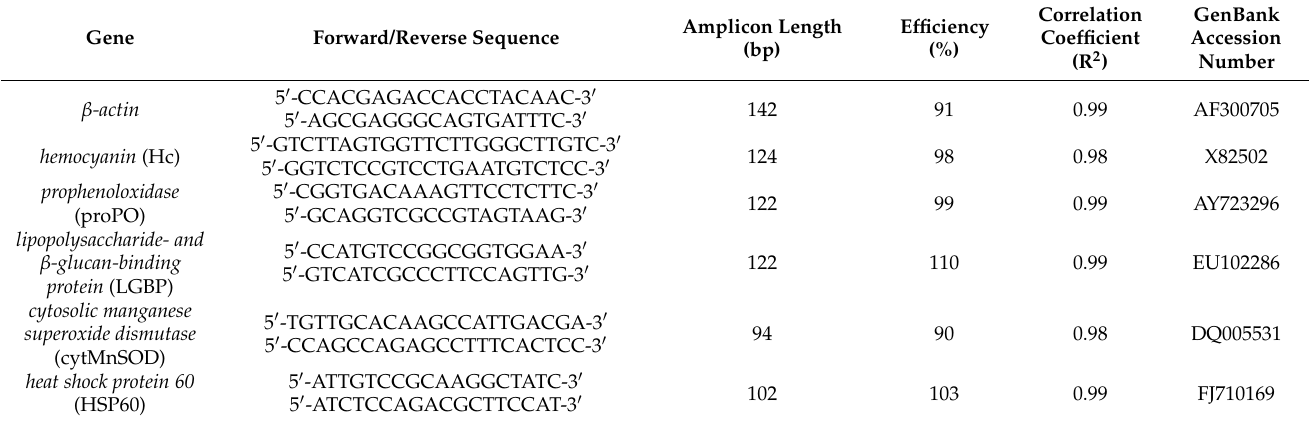
Table 2. Specific primers used for transcriptional response of immune related genes of L. vannamei